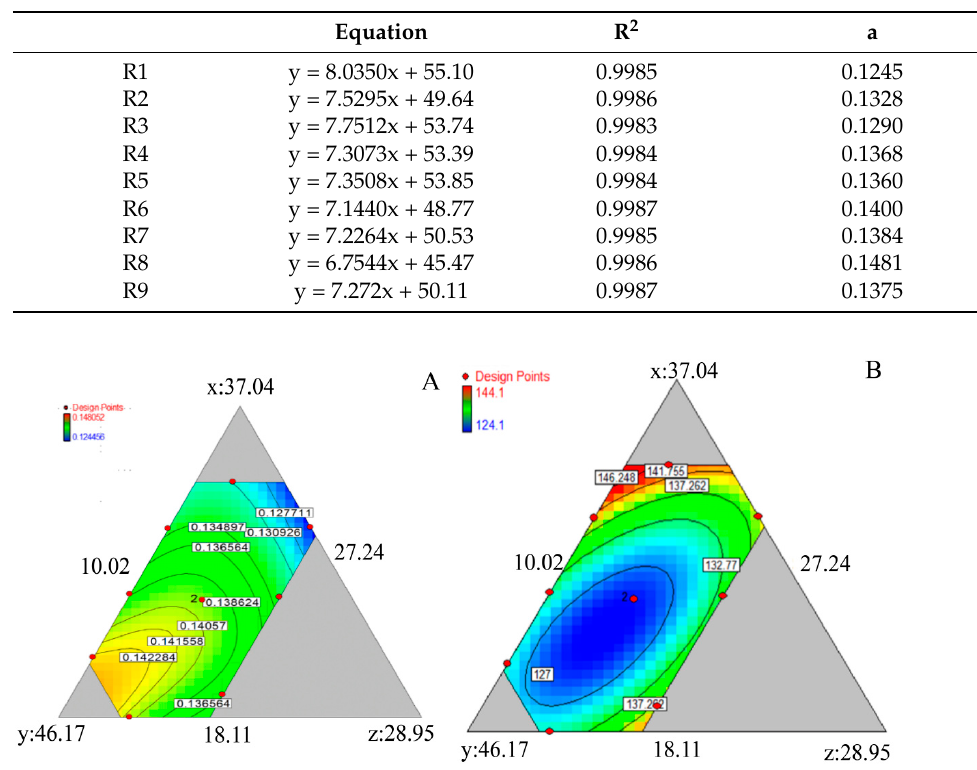
Figure 4. Effects of each factors on a value ( A ) and Py value ( B ). x: lactose monohydrate (SuperTab ® 14SD), y: MCC PH102, z: pre-gelatinized starch.